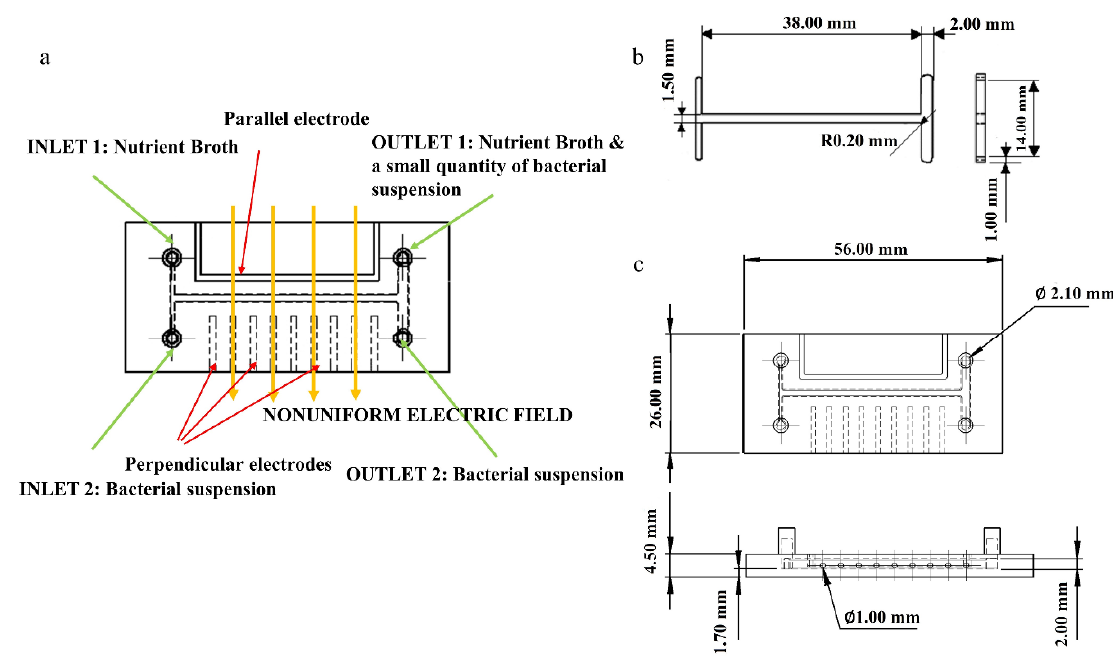
Figure 1. Schematic representation of the microfluidic bioreactor: ( a ) overview of the main components of the device; ( b ) overall dimensions of the central channel; ( c ) top and side view of the microfluidic bioreactor, with overall dimensions.